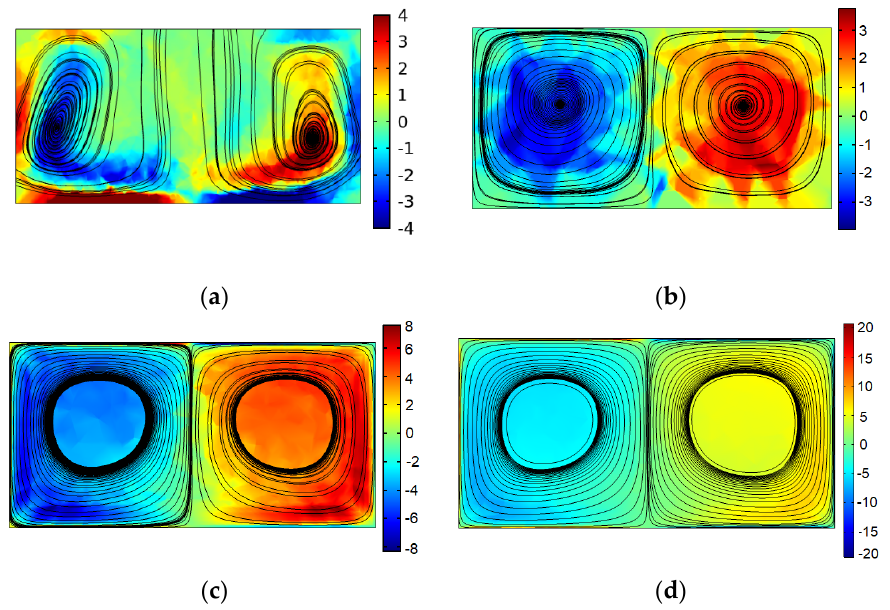
Figure 9. Panel ( a ) shows the circulation zone captured using laminar modeling; ( b ) Partial Refine- ment results in 5498 tetrahedron elements in the drainage tank, a minimum element quality of 0.6541, and an element volume ratio of 0.001275; ( c ) Global “Coarser Mesh” mesh with Turbulent model with 14,681 mixed elements, a minimum element quality 0.1307, and an element volume ratio 0.0021; and ( d ) Global Mesh refinement with “Normal” mesh with Turbulent model with 61,052 mixed elements in the drainage tank, a minimum element quality of 0.1251, and an element volume ratio of 9.8 × 10 − 4